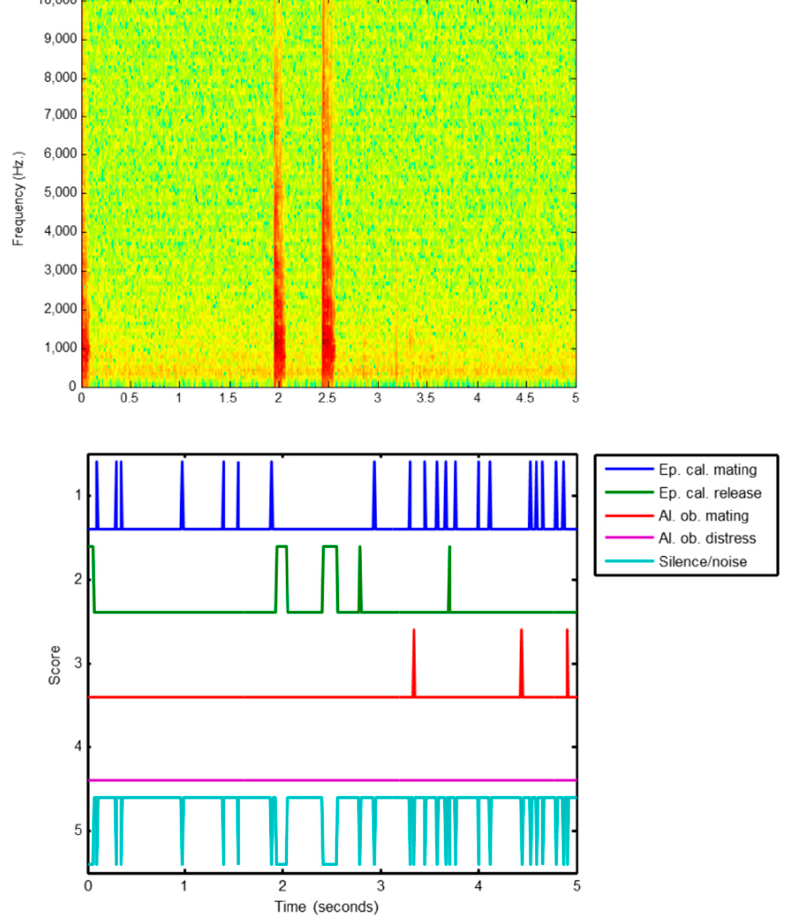
Figure 1. Example of misclassification. Figure 4. Example of